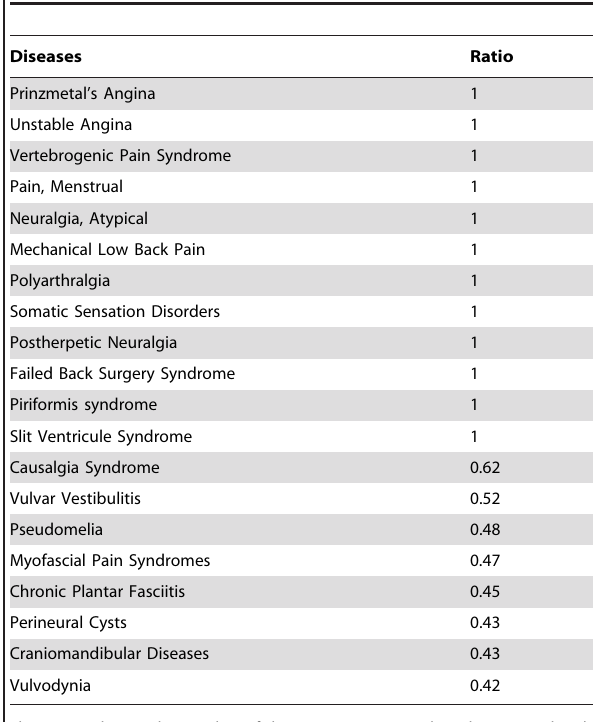
Table 1. The 20 diseases with the highest disease-pain ratio from the DSPI are listed out of a total of 2962